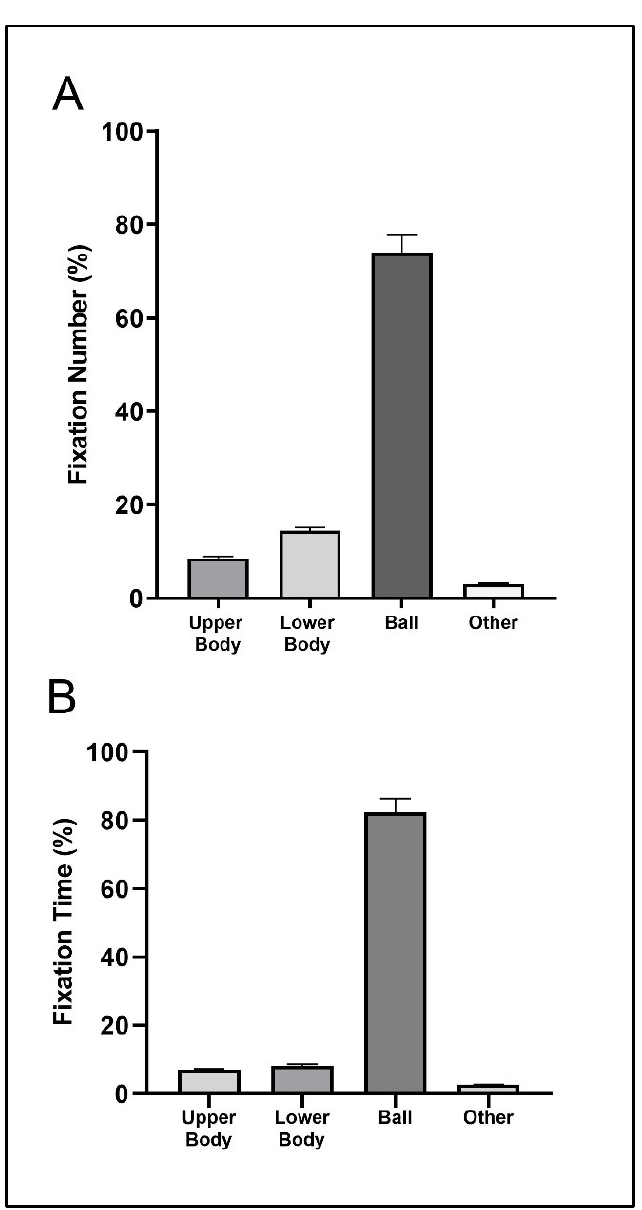
Figure 4. Mean (bar) and standard deviation (error bars with 95% confidence interval) of the relative fixation number ( A ) and fixation time ( B ) for the serve return situation.